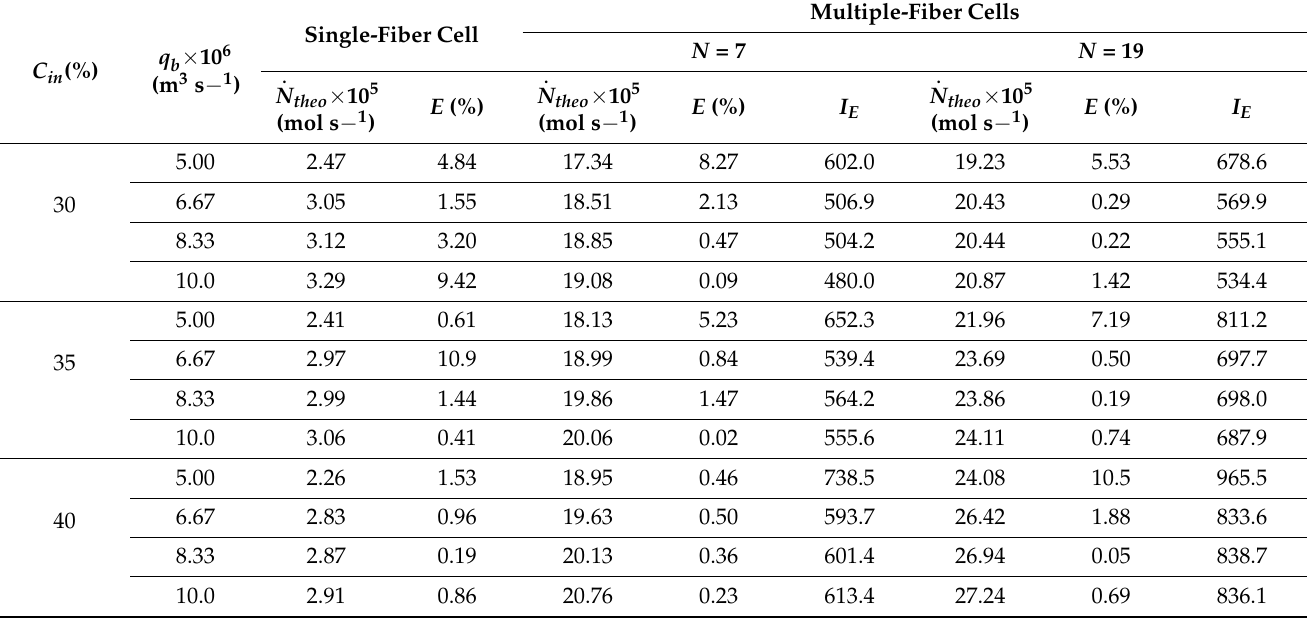
Table 2. Effects of MEA flow rate and various fiber cells on I E for countercurrent-flow operations.